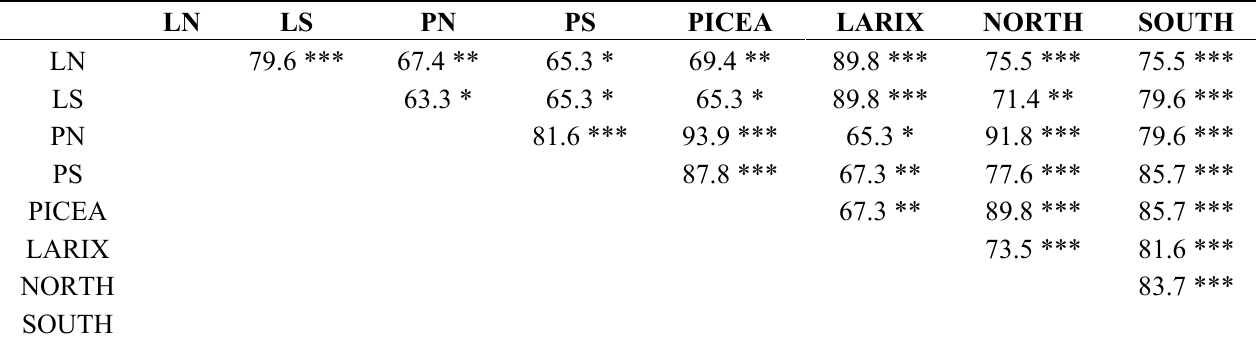
Table 3. Gleichläfigkeit values (%) between different